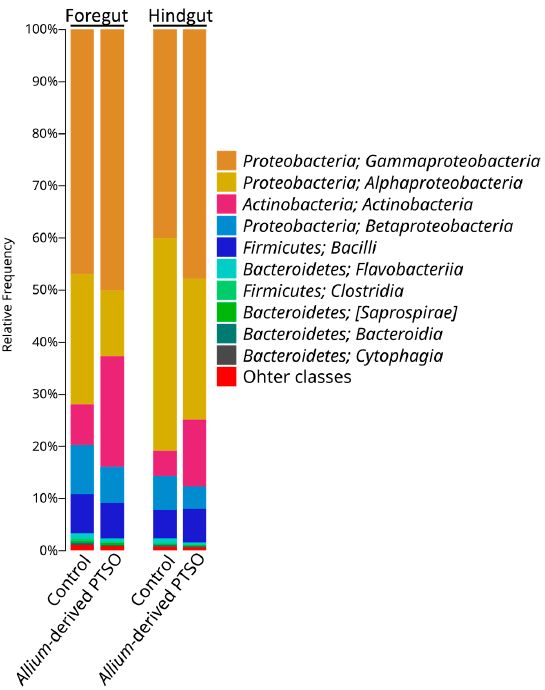
Figure 2. Microbial composition at the class level of juvenile European seabass gut microbiota group by experimental diet (control and Allium -derived PTSO). Classes in the legend are sorted from most abundant to lowest abundant.